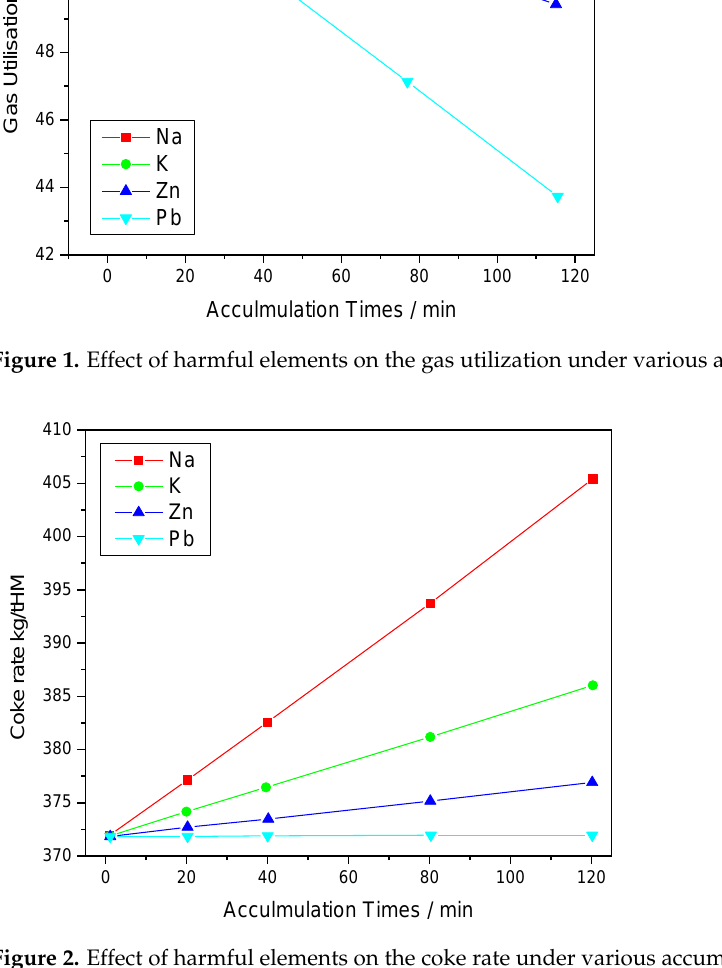
Figure 2. Effect of harmful elements on the coke rate under various accumulation times.